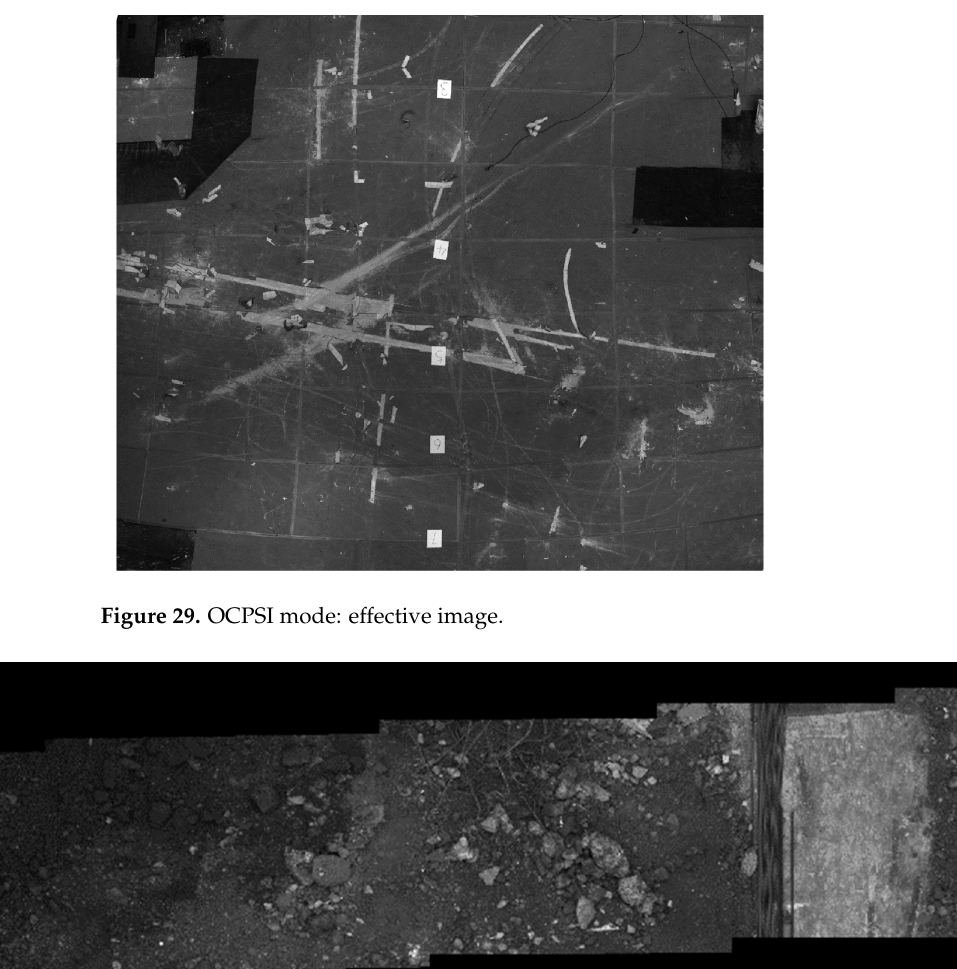
Figure 30. Push-broom ground test cover diagram.